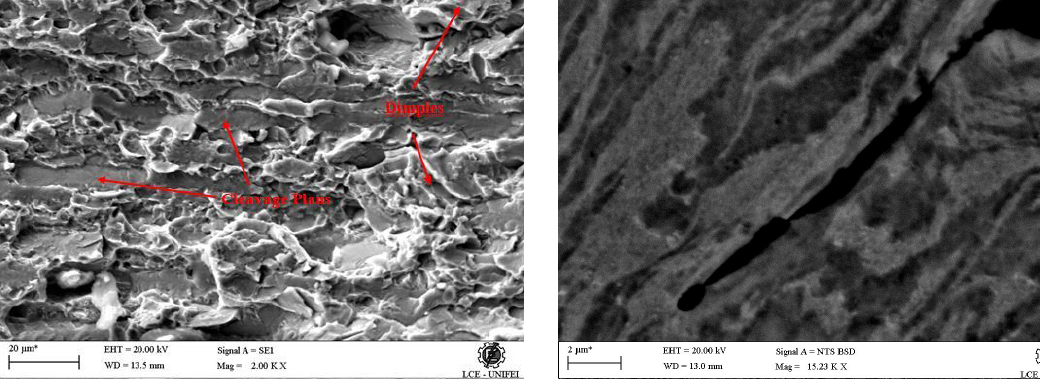
Figure 9. DA Sample: Mixed Fracture Aspect in Peripheral Region.